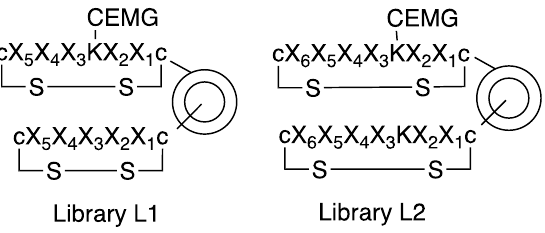
Figure 5. Structures of two OBOC illuminating peptide libraries, where the MRD moiety is introduced within the library onto an amino group of the lysine (K) side chain. X stands for 19 natural amino acids except L -cysteine.